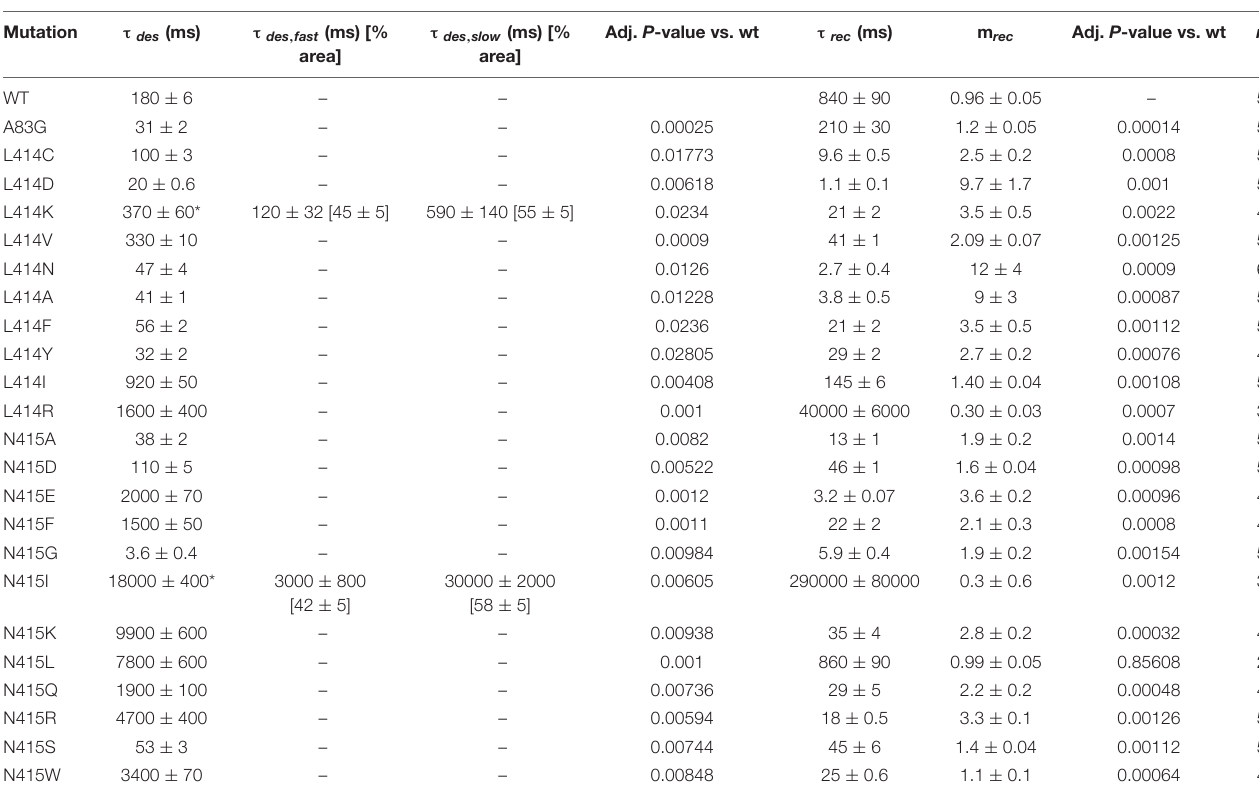
TABLE 1 | Time constants of desensitization and